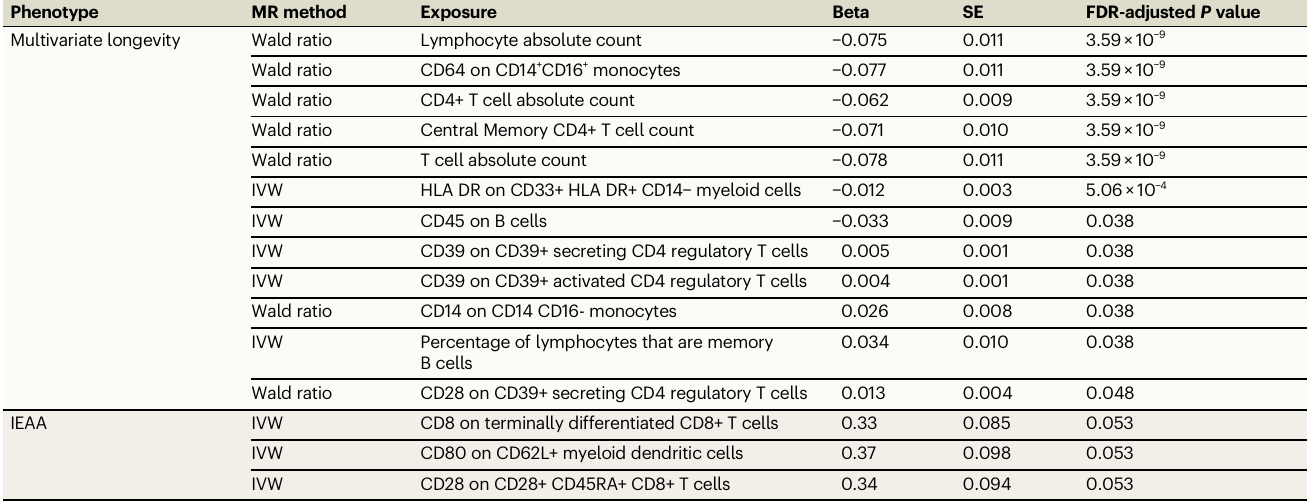
Table 3 | MR identi fi es immune cell traits associated with aging phenotypes Phenotype MR method Multivariate